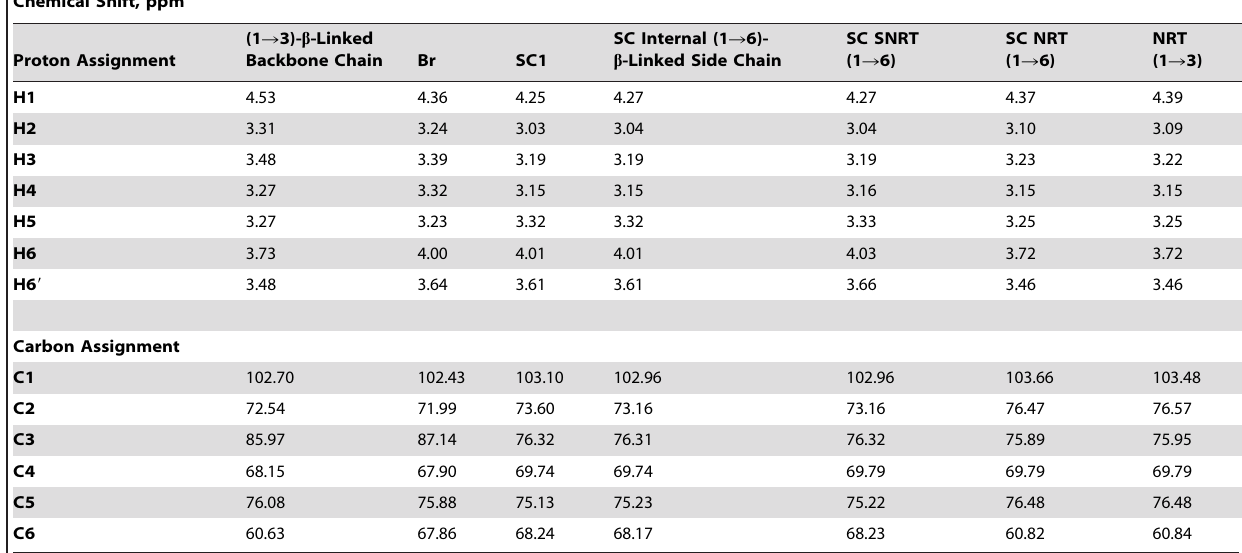
Table 1. Proton (top) and 13 C (bottom) NMR chemical shifts (in ppm) for structural features characterized in the glucan isolated from C. glabrata ace2 (HLS122)